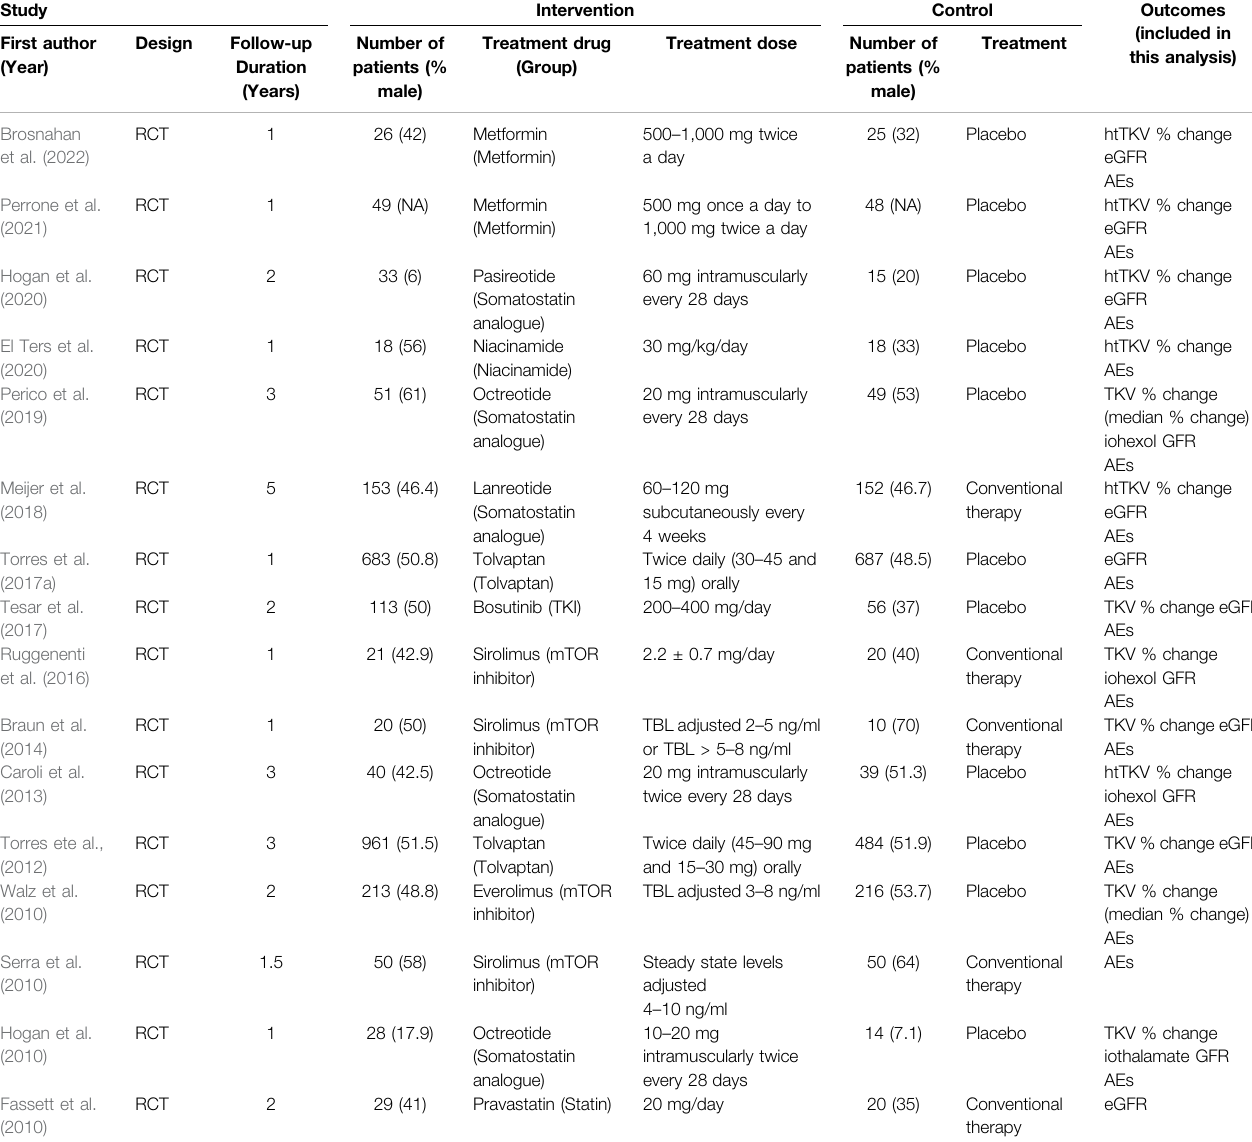
TABLE 1 | The characteristics of the included studies.